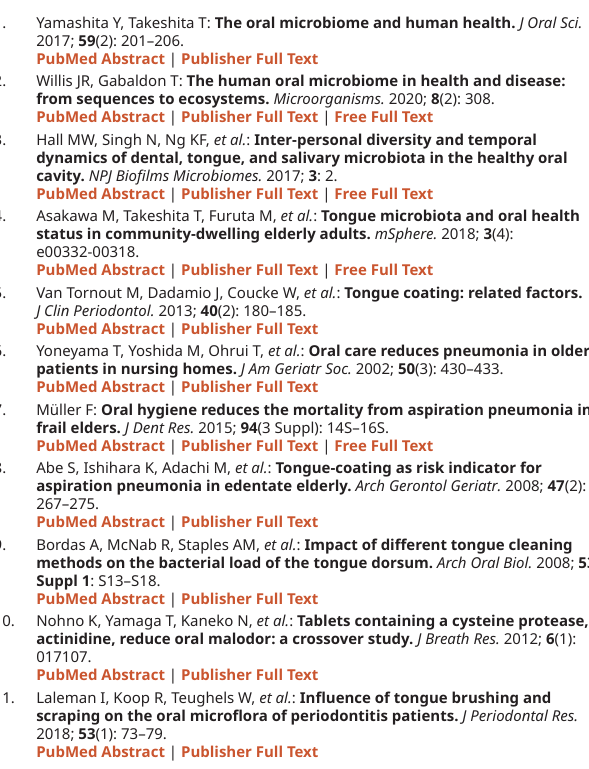
Figshare: Table_S1_sample-metadata.tsv for “Inter-site and interpersonal diversity of salivary and tongue microbiomes, and the effect of oral care tablets”. https://doi.org/10.6084/ m9.figshare.13289618.v1 37 Table_S1_sample-metadata.tsv: Columns indicate sample ID, participant, sampling date (D1 or D2), treatment, Miseq run number, and sampling body site (saliva or tongue) of each sample. The “treatment” column indicates, no tablet (E2), protease tablet (E3), or plain tablet (E4) treatments.